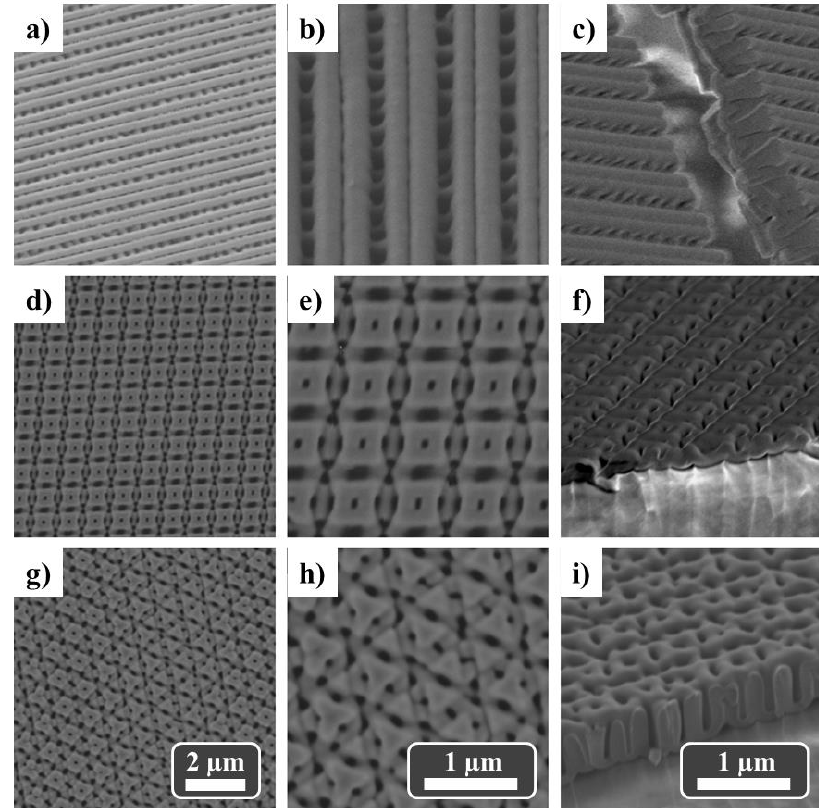
Figure 5. Top-view ( a , b , d , e , g , h ) and cross-section ( c , f , i ) SEM images of PAA templates with line ( a – c ), square ( d – f ) and triangular configurations ( g – i ) imprinted using DVD-PS/ML molds and a single anodization step under constant voltage of 195 V in 0.03M H 3 PO 4 solution at 5 °C and for 2 h.